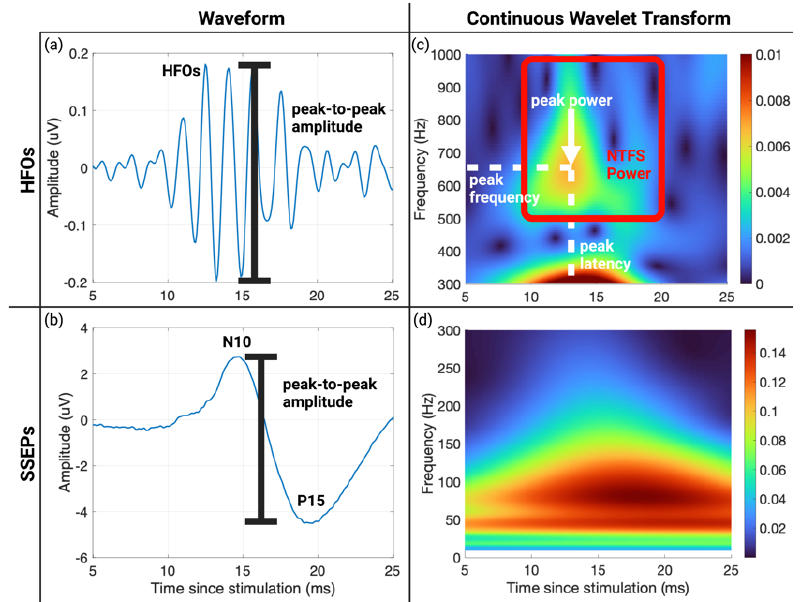
Figure 2. Parameter extraction from high-frequency oscillations (HFOs) and SSEPs in the time and time-frequency domain. ( a ) Grand averaged ( n = 11 subjects) HFO waveform during anesthesia washout. The largest peak-to-peak amplitude was extracted as the parameter. ( b ) Grand averaged SSEP waveform during anesthesia washout. The N10-P15 peak-to-peak amplitude was extracted as the parameter. ( c ) Continuous wavelet transform (CWT) successfully isolated HFOs as a single peak around 600 Hz and 13 ms in the time-frequency domain. The color axis represents the signal power at a particular time and frequency. The peak latency, peak frequency, peak power, and the total power in the normal time-frequency space (NTFS) were used to characterize HFOs in the time-frequency (TF) domain. ( d ) SSEPs in the time-frequency domain using CWT. SSEP formed a single peak around 100 Hz and 20 ms. Created with Biorender.com.